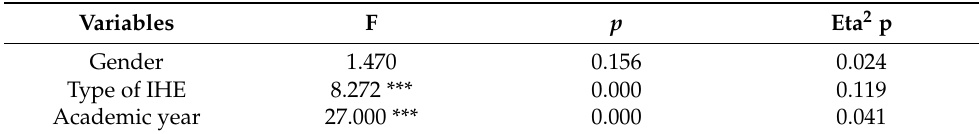
Table 3. Main effects of the comparison variables.